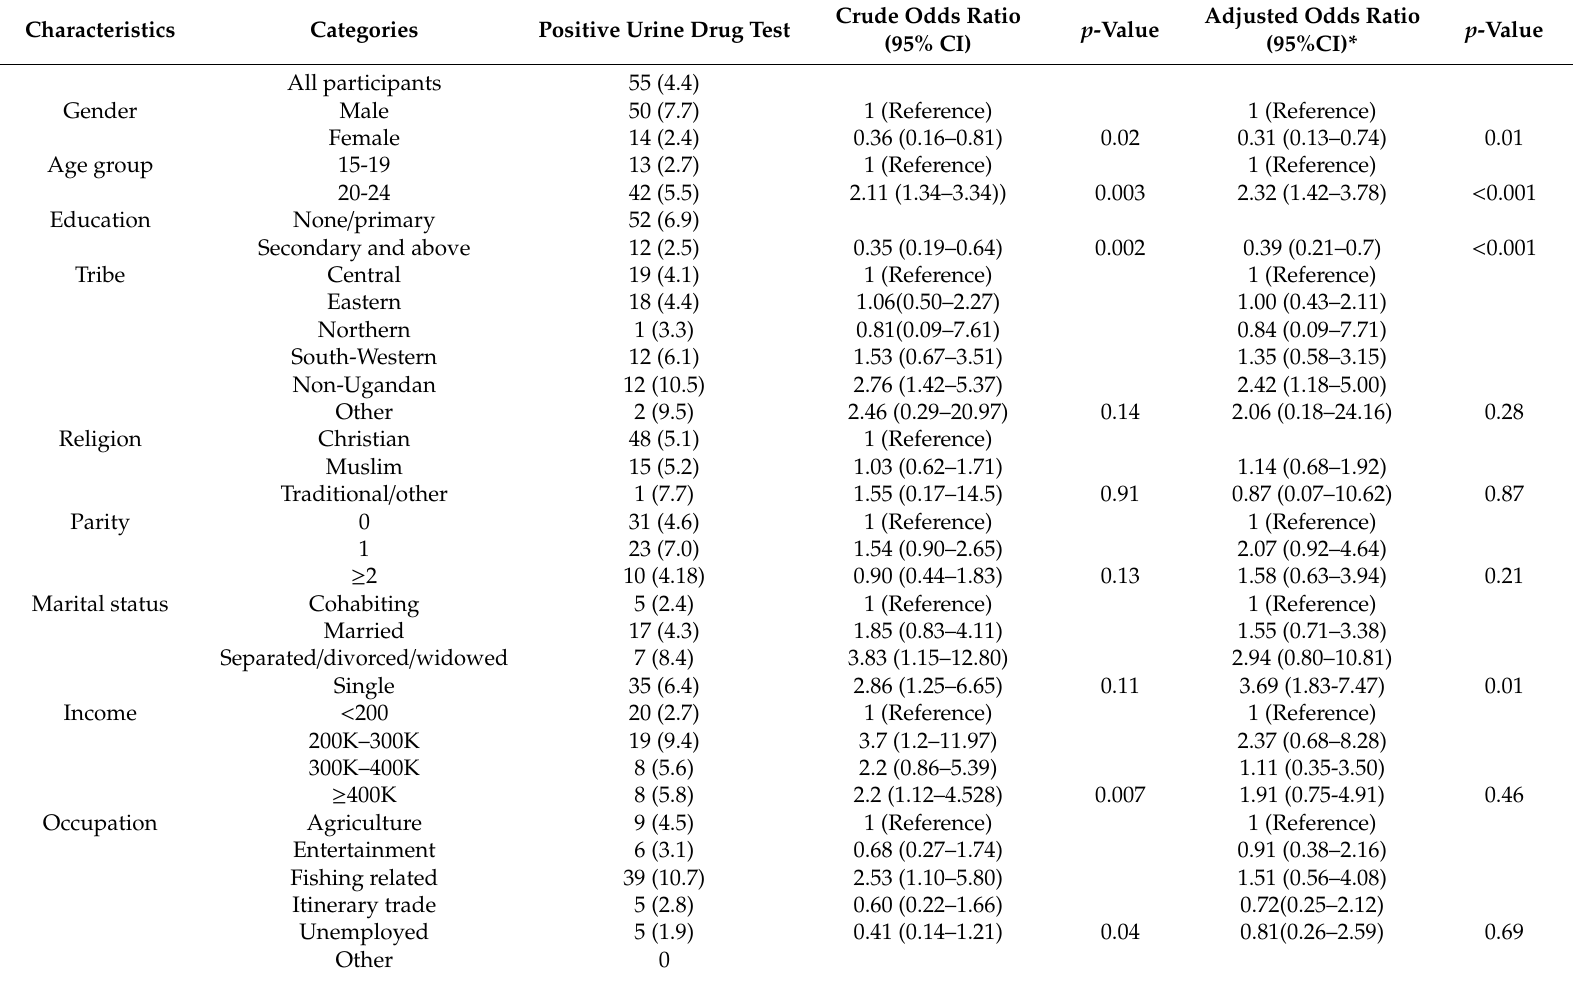
Table 5. Risk factors for illicit drug use among young people aged 15–24 years in fishing communities in Uganda.